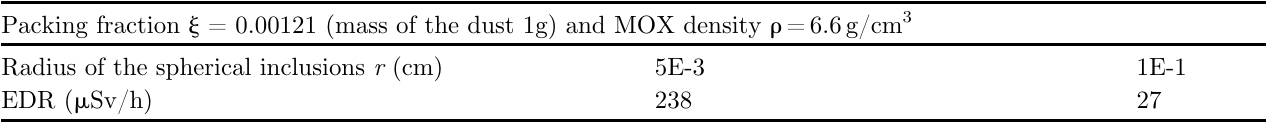
Table 3. Equivalent dose rate calculated for different values of the radius of the source spheres.